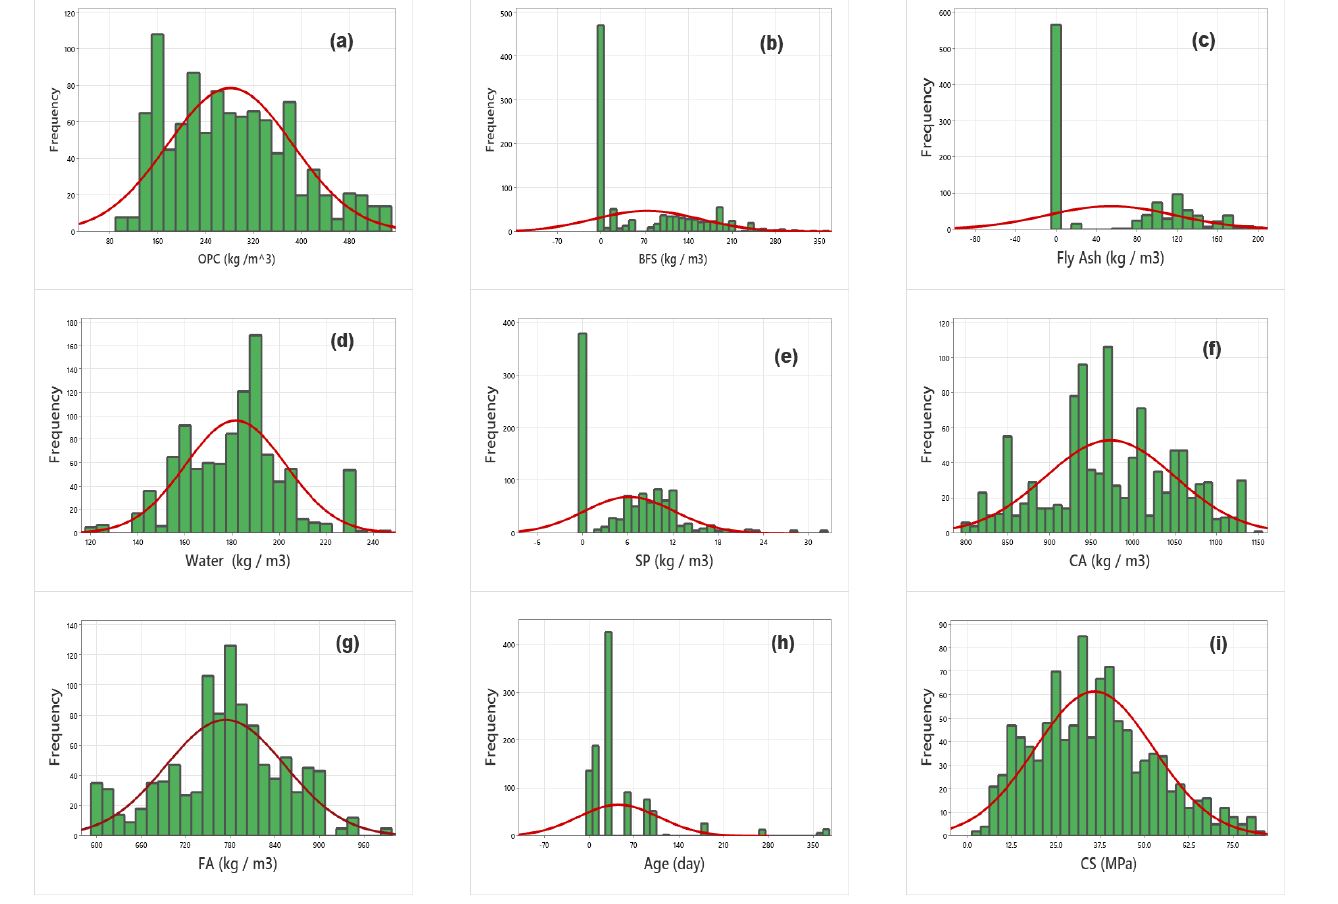
Figure 4. Frequency distribution plot for variables factors ( a ) OPC, ( b ) BFS, ( c ) Fly Ash, ( d ) Water,